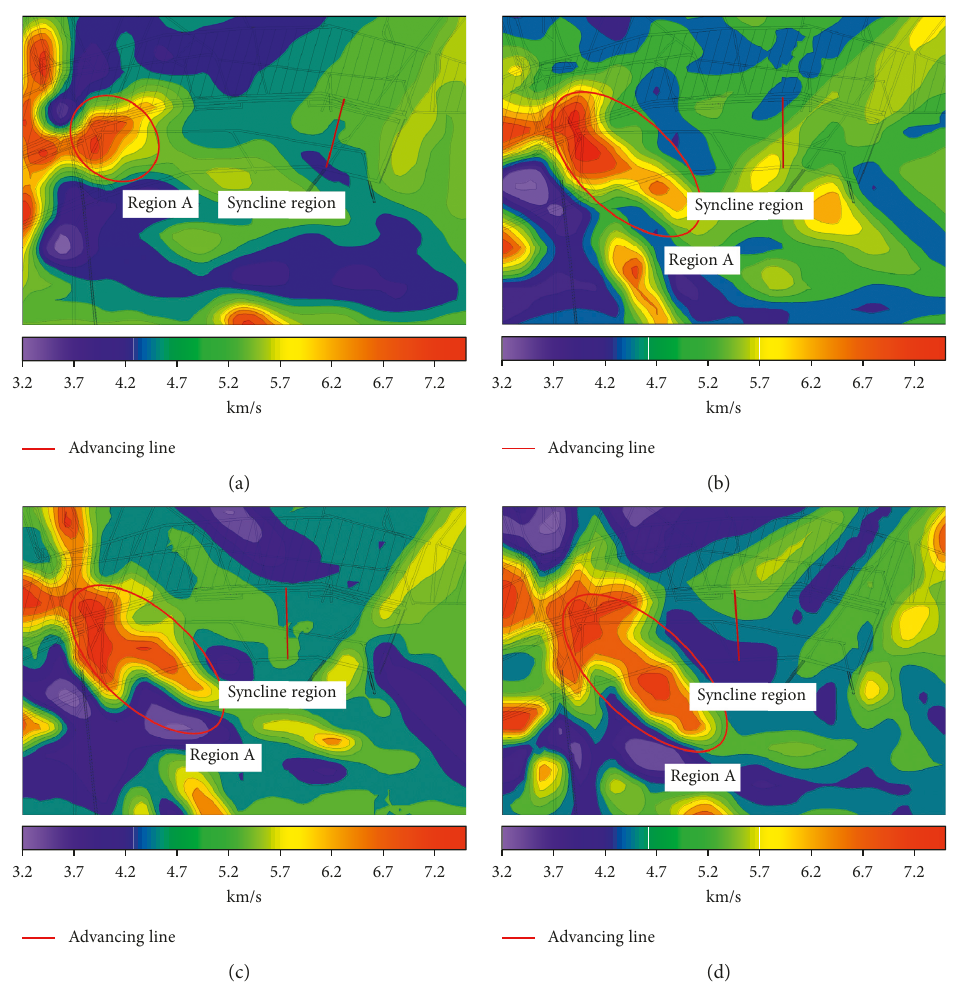
Figure 4: Seismic velocity tomography results at different advancing distances during